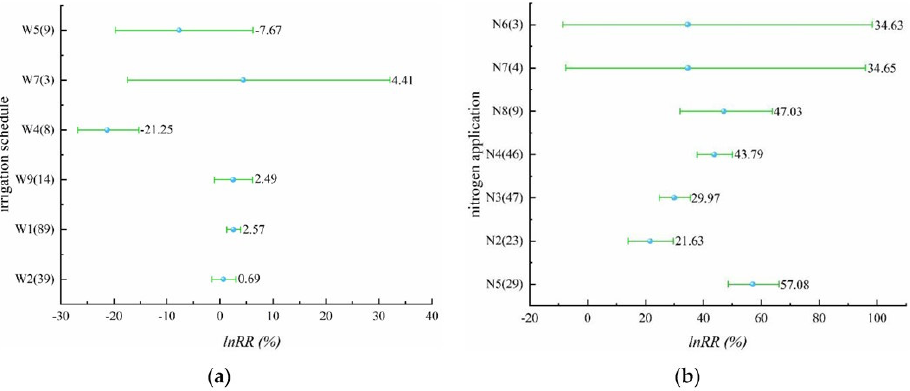
Figure 1. ( a ) Effect of different irrigation schedules on rice yield ( p = 0.00000); ( b ) effect of different nitrogen application levels on rice yield ( p = 0.00011).